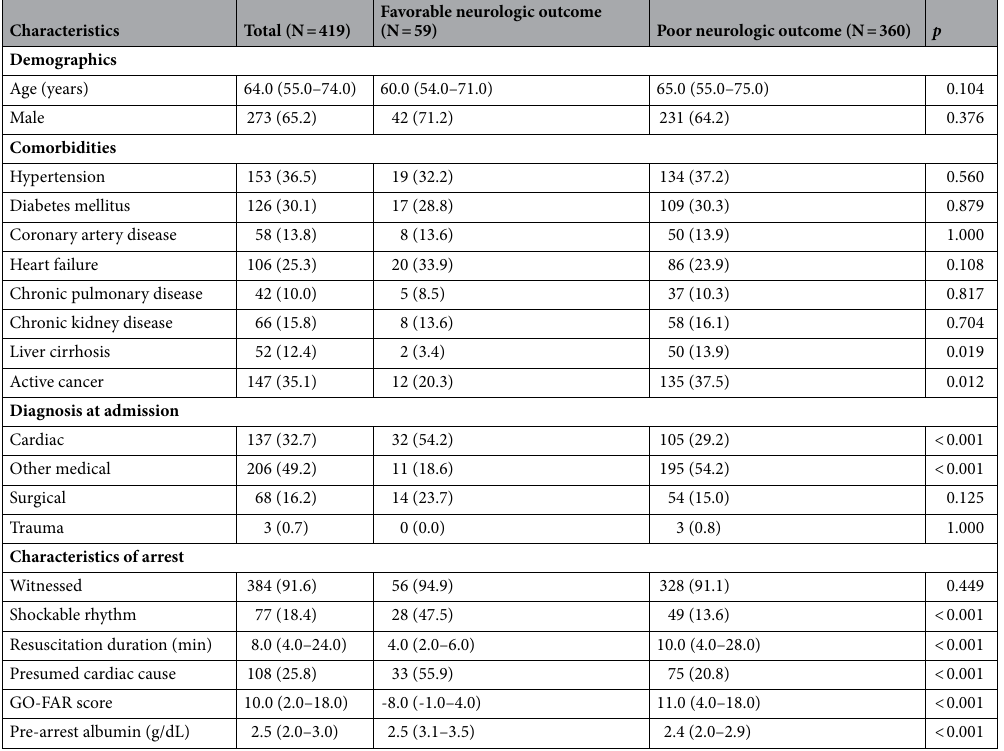
Table 1. Clinical characteristics of included patients in the derivation cohort. Data are presented as n (%) or median with interquartile ranges. GO-FAR score Good Outcome Following Attempted Resuscitation